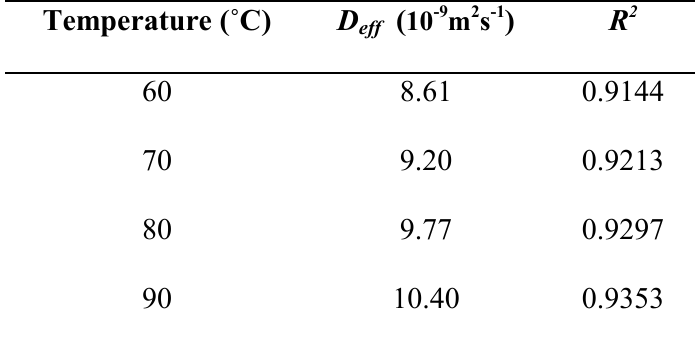
Effective moisture diffusivity in different